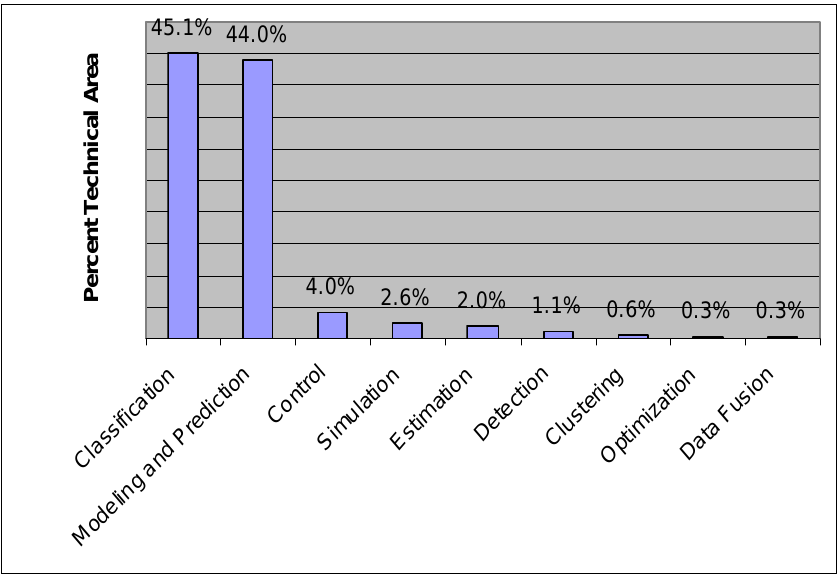
Figure 11. Technical area distribution of ANNs in agricultural and biological